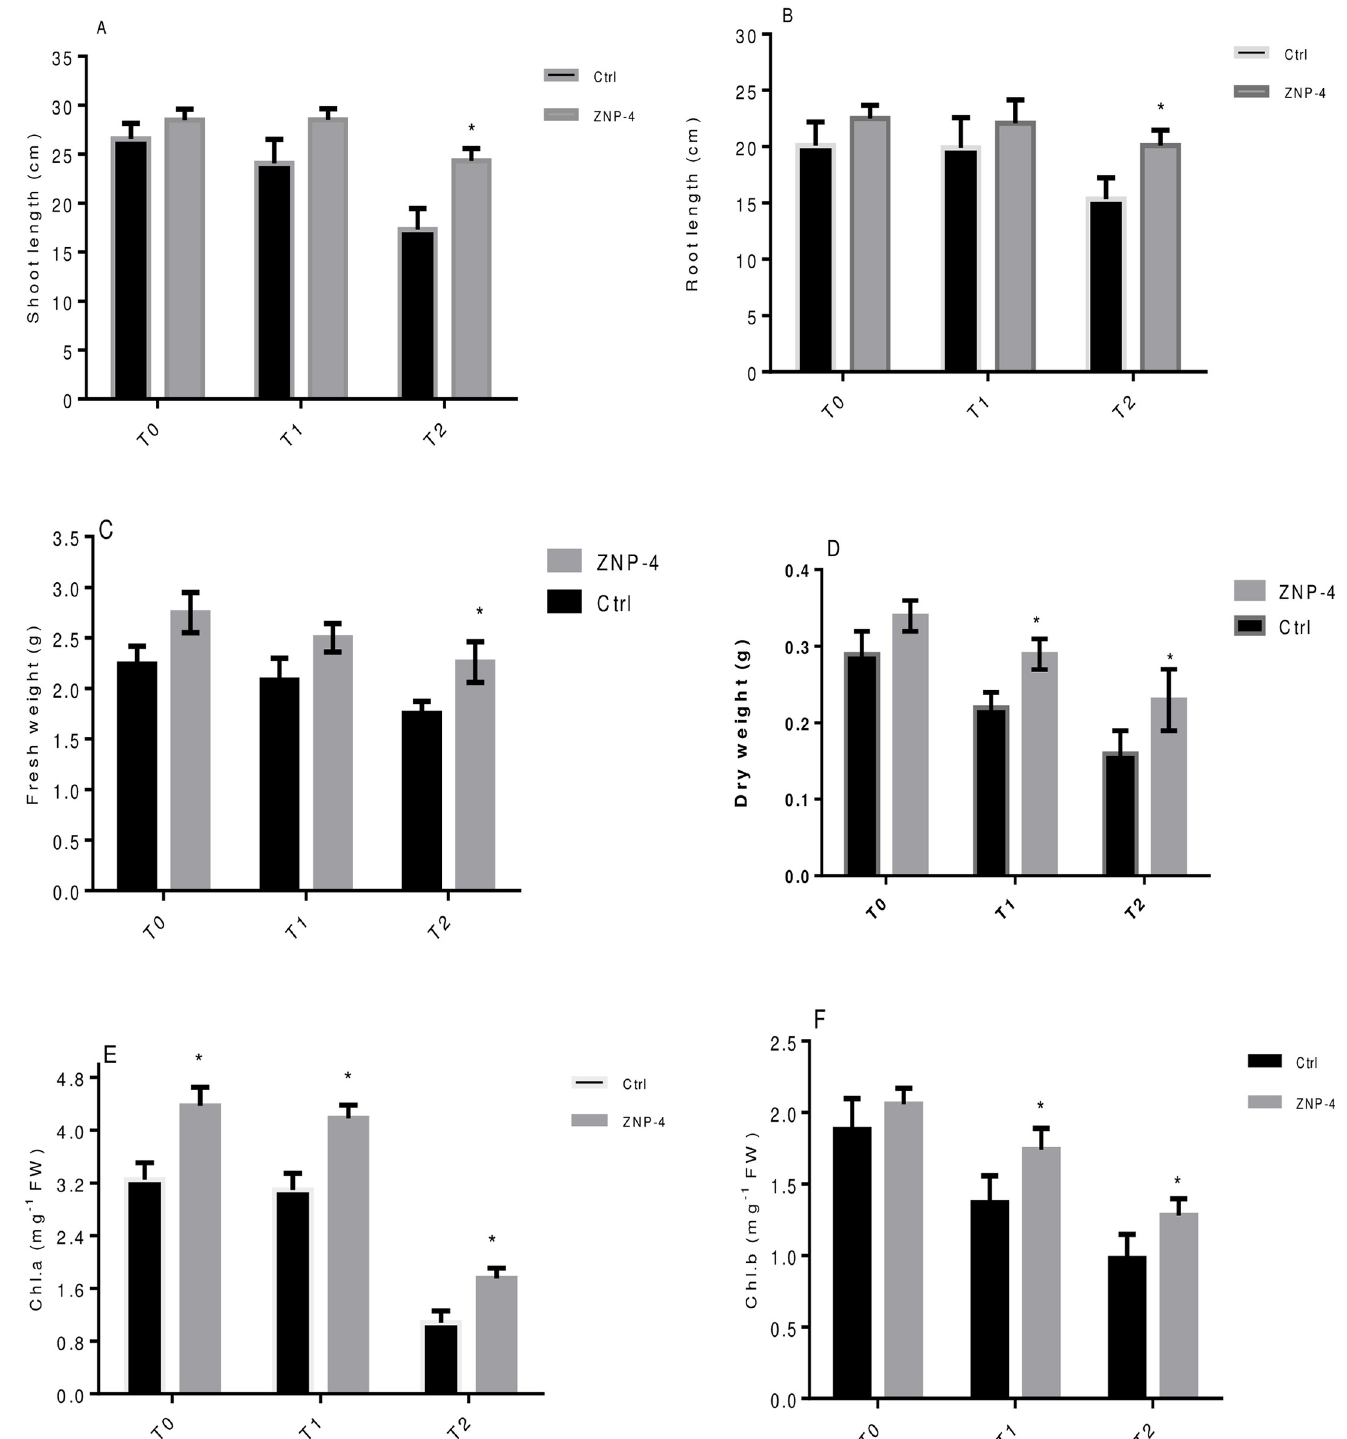
Fig 4. Effect of inoculation with bacterium ZNP-4 on plant growth and chlorophyll contents under different salinity conditions (T0: 0 mM; T1: 150 mM, T2: 200 mM NaCl) (A) shoot length (B) root length (C) fresh weight (D) dry weight (E) chlorophyll a (F) chlorophyll b. Values are mean ± SD of triplicate sets (n = 15). � represent the significant difference as compared to respective control according to Ducan’s multiple range test (p = 0.05).